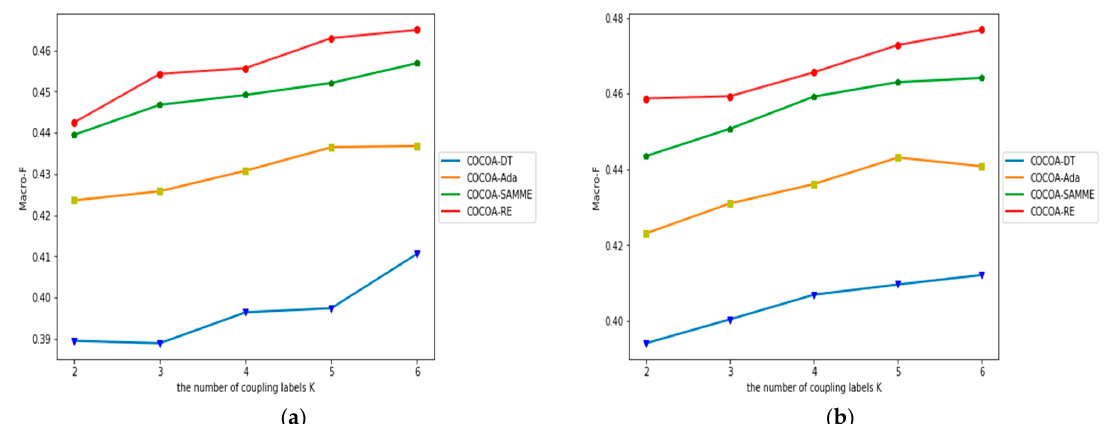
Figure 3. Comparative Macro-F values with changing coupling labels: ( a ) the Macro-F values of different K when the binary classifier is decision tree; ( b ) the Macro-F values of different K when the binary classifier is neural network.